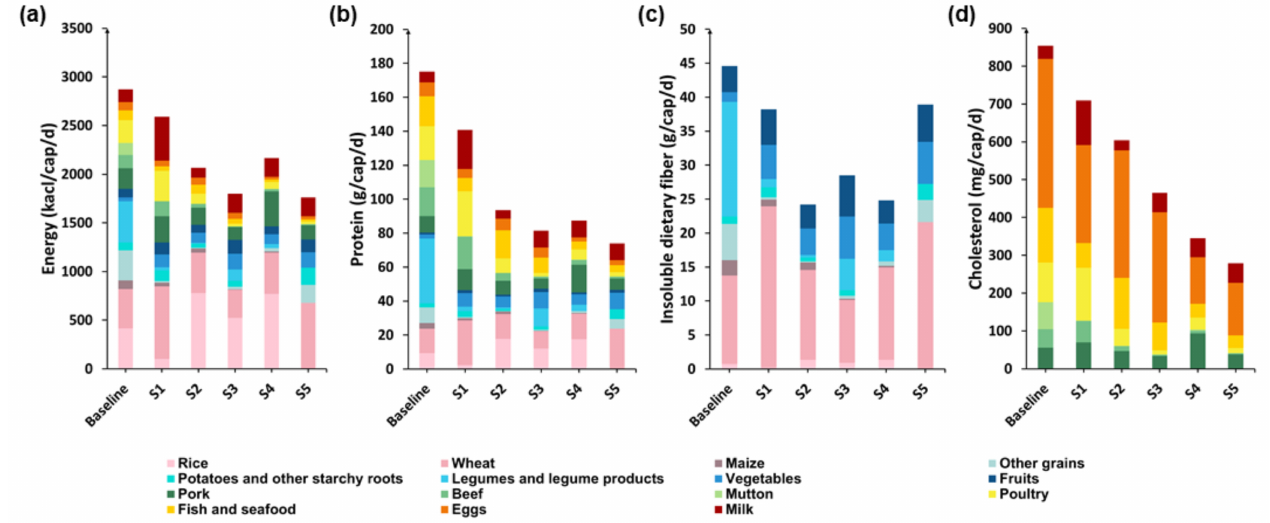
Figure 10. Scenarios analysis for nutrient intake of household under different dietary patterns (( a ) energy intake; ( b ) protein intake; ( c ) insoluble dietary fiber intake; ( d ) cholesterol intake; Baseline: CHN 2011 [37]; S1: US 2015 [41]; S2: JPN 2015 [42]; S3: Chinese Dietary Guidelines 2016 [43]; S4: Guideline of Australia 2013 [44]; S5: guidelines issued by Germany 2013